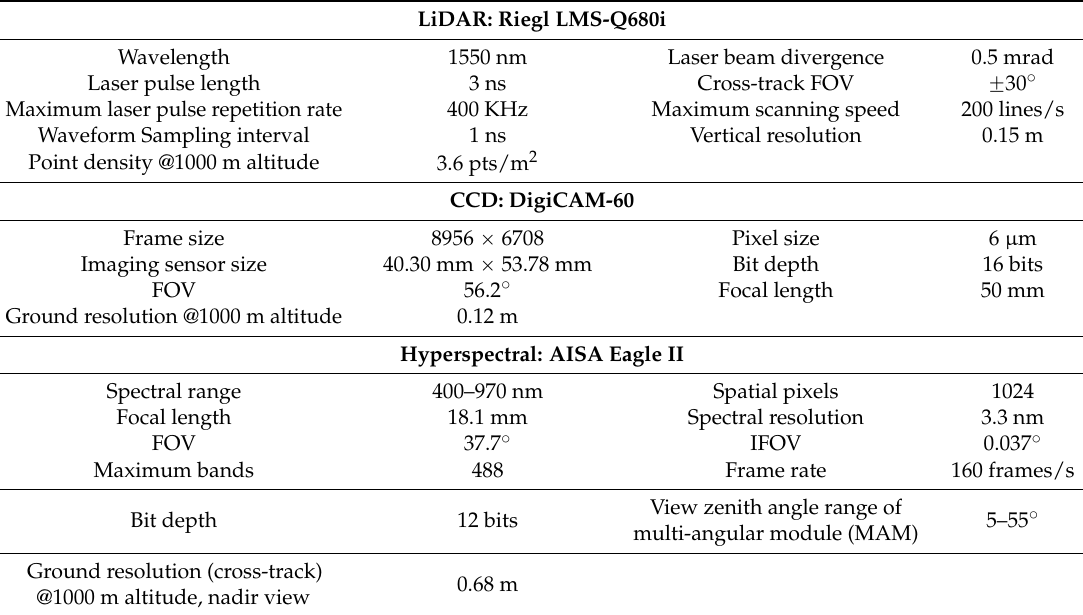
Table 1. The sensor parameters of LiCHy